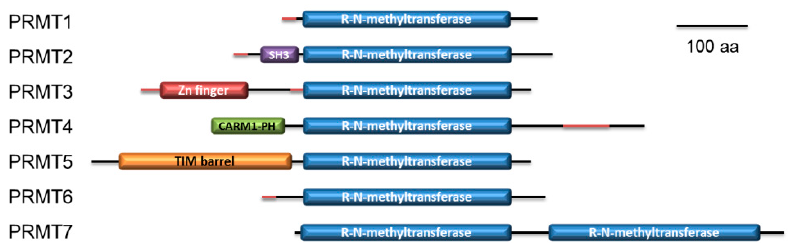
Figure 5. Schematic representation of the seven P. lividus PRMT isoforms and their domains predicted by InterPro (drawn to scale). SH3: SRC homology 3 domain; Zn finger: Zinc finger C2H2 superfamily; CARM1/PH: Histone-arginine methyltransferase CARM1, N-terminal / PH-like domain superfamily; TIM barrel: PRMT5, TIM barrel domain; R-N-methyltransferase: SAM-dependent methyltransferase PRMT-type domain. The protein regions predicted as disordered are depicted in red.